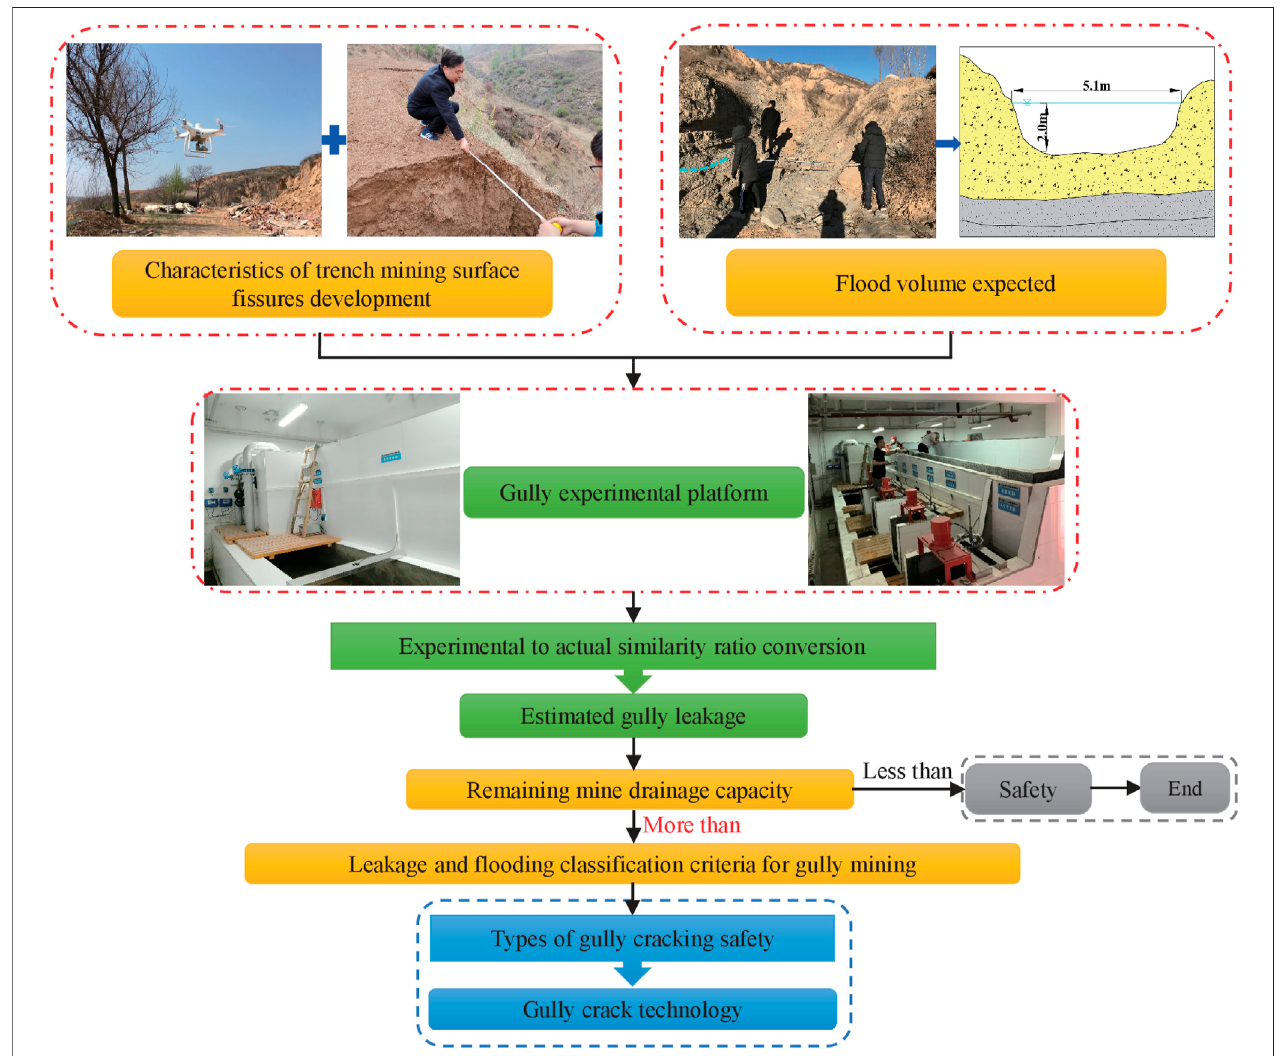
FIGURE 3 | Flow chart for prediction and treatment of water leakage